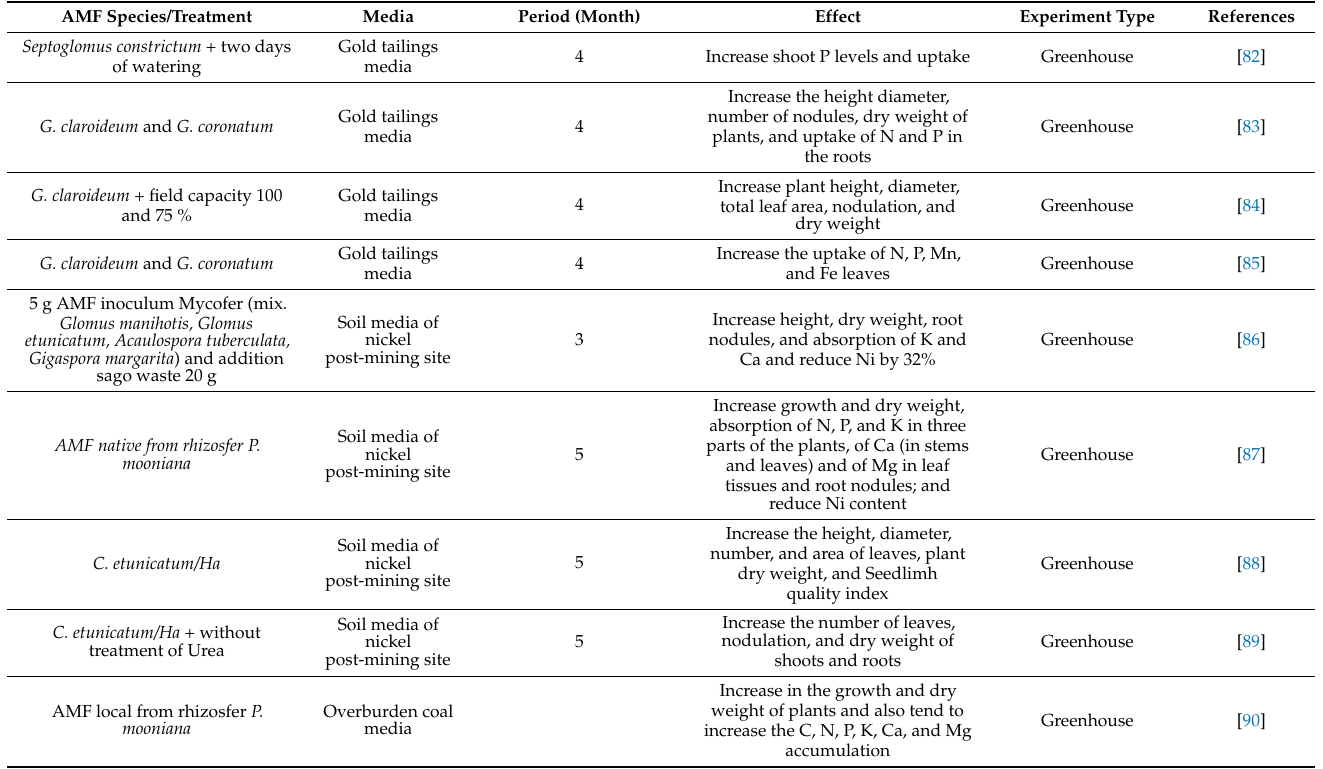
Table 1. Review of AMF symbiotic research with P. mooniana